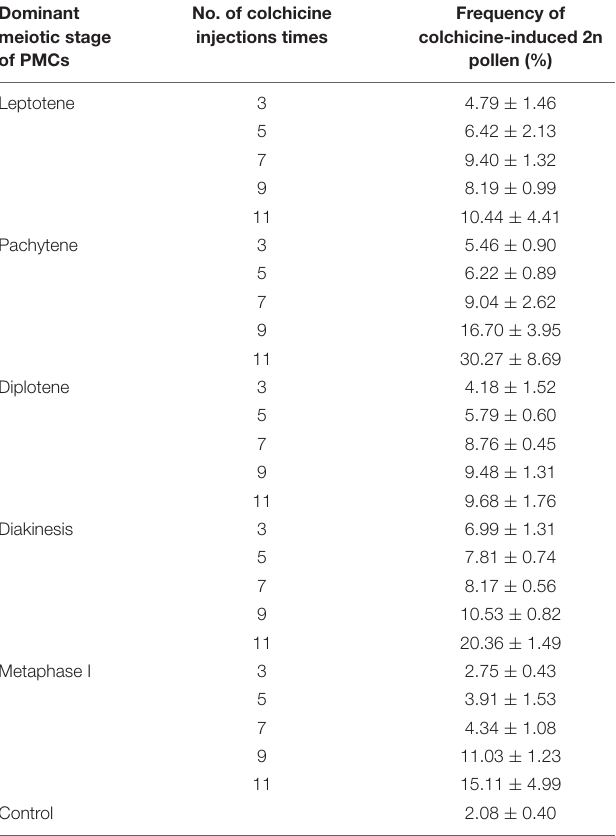
TABLE 1 | Induction of 2n pollen via a 0.5% colchicine solution in P. canescens. Dominant meiotic stage of